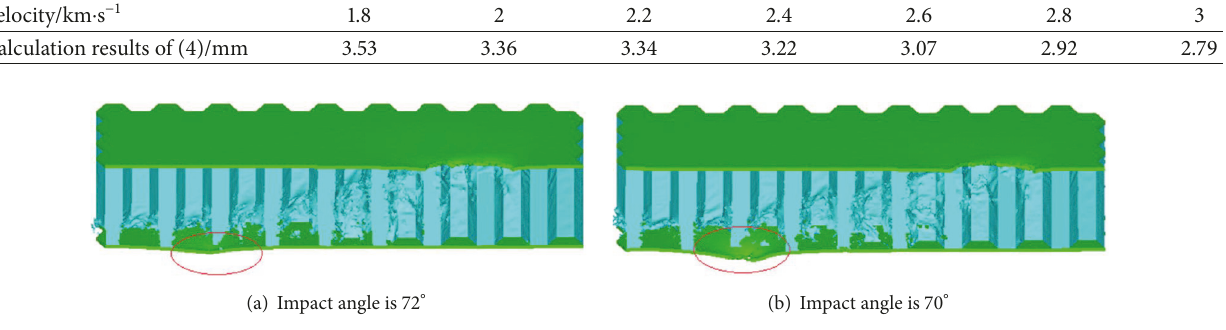
Figure 10: Damage of rear face sheet with critical perforated.